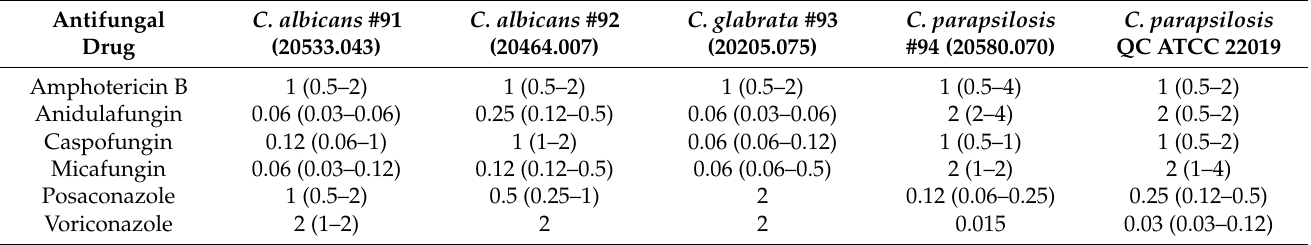
Table 1. The minimal inhibitory concentrations of six antifungal drugs against the five test Candida isolates determined with the Sensititre Yeast colorimetric broth microdilution